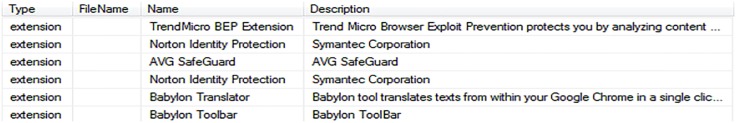
User addons record: Sample user 2.